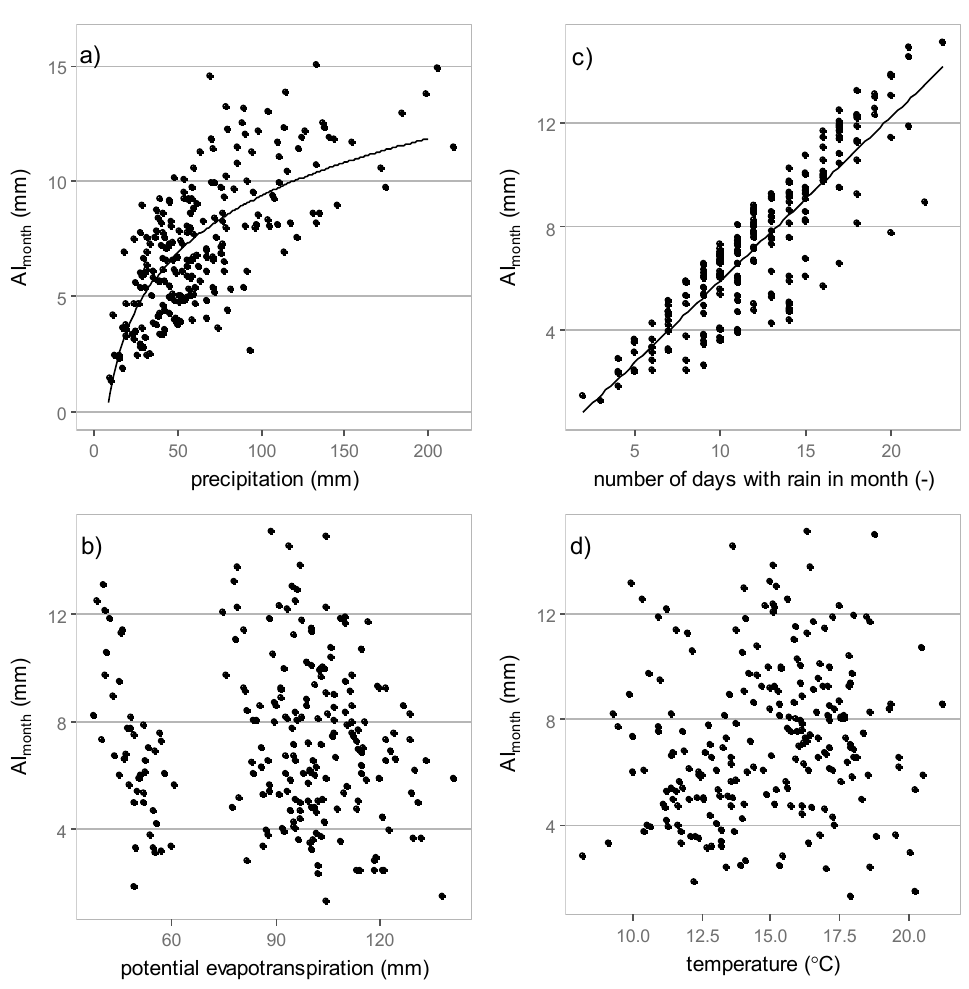
Figure 8. Relationship between absolute month interception (AI month ) and: ( a ) sum of precipitation; ( b ) sum of potential evapotranspiration; ( c ) number of days with rain; ( d ) mean temperature.